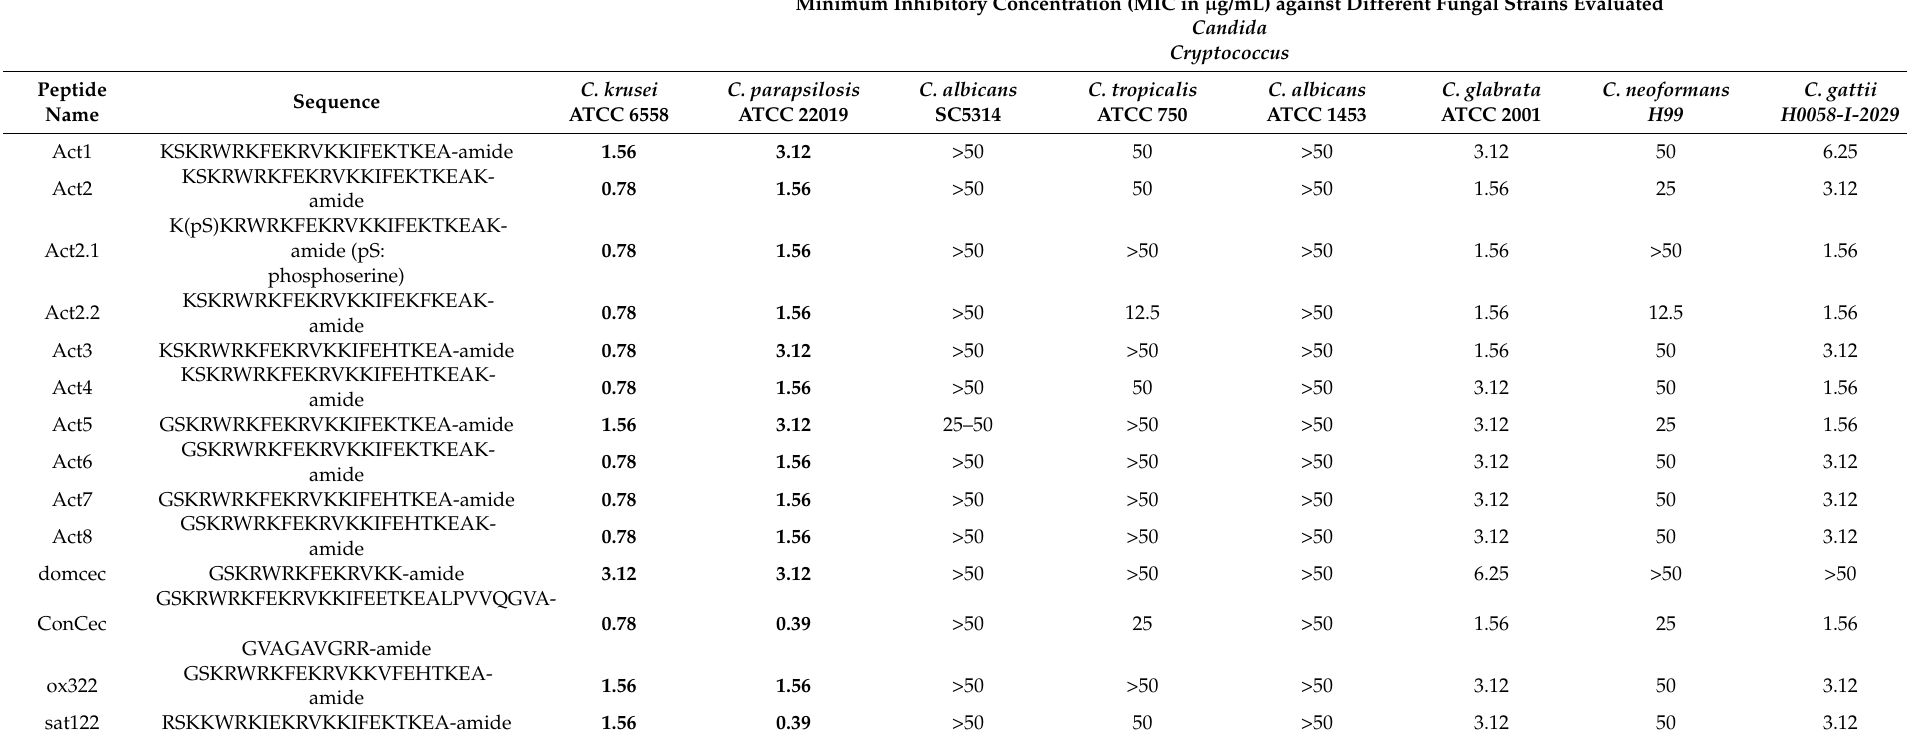
Table 1. Minimum Inhibitory Concentrations (MICs) of 14 peptides